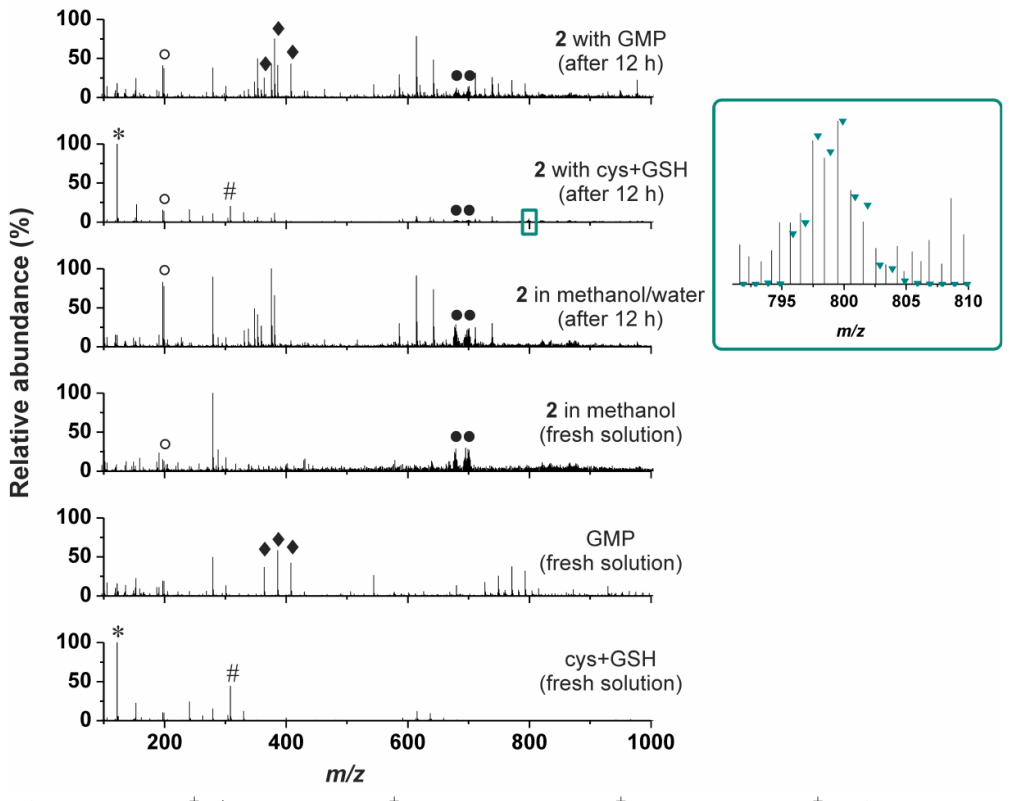
Figure 2. The ESI+ mass spectra (recorded on fresh solutions and after 12 h) for the stability in methanol/water mixture, and for the interaction of the representative complex 2 with the mixture of cysteine and reduced glutathione (cys+GSH), and guanosine 5'-monophosphate (GMP), given together with the spectra of the fresh solutions of the individual reactants, i.e. , the complex 2 , cys+GSH mixture and